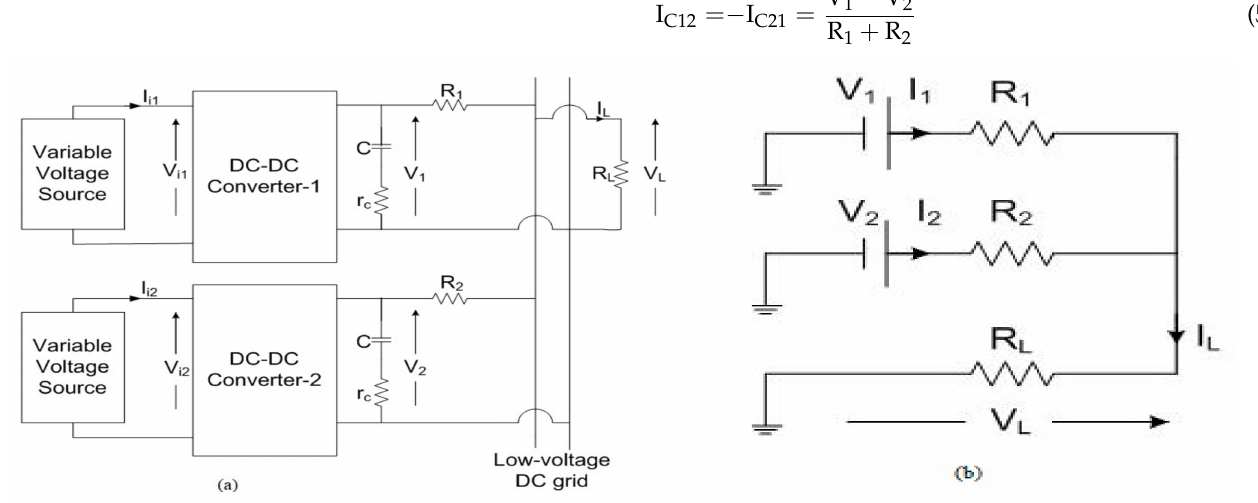
Figure 2. ( a ) Parallel DC–DC buck converter. ( b ) Equivalent